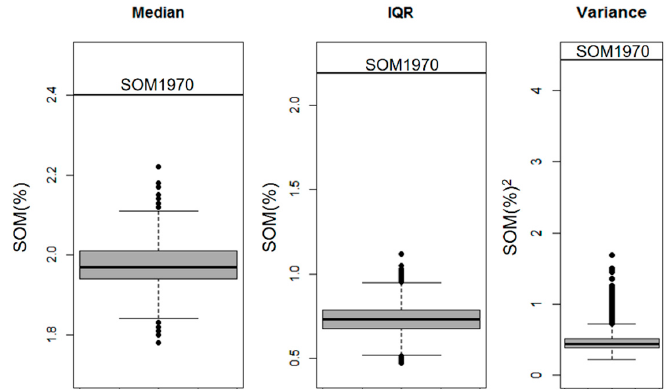
Figure 5. Boxplots report the statistical distribution (including extremes) of the statistical indices (median, interquartile range, and variance) calculated from each of the 10,000 subsamples (subsam- pling ratio 0.8%) generated from the SOM2010 dataset. The horizontal thick black lines represent the respective statistical index (i.e., median, interquartile range, and variance) calculated from the SOM1970 dataset.